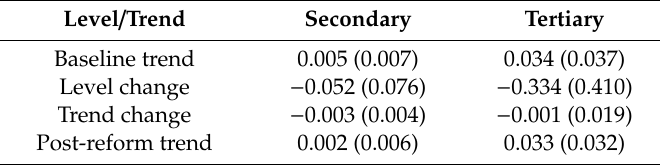
Figure 5. The ITS analysis of monthly inpatient visits per secondary hospital. Model adjusted for seasonality. Solid line: predicted trend based on the seasonally adjusted regression model and autocorrelation. Dashed line: de-seasonalized trend. Vertical line: intervention began. Blue dots: actual number. Table 6. The impacts of the Beijing Reform on monthly inpatient visits per healthcare facilities. Level /